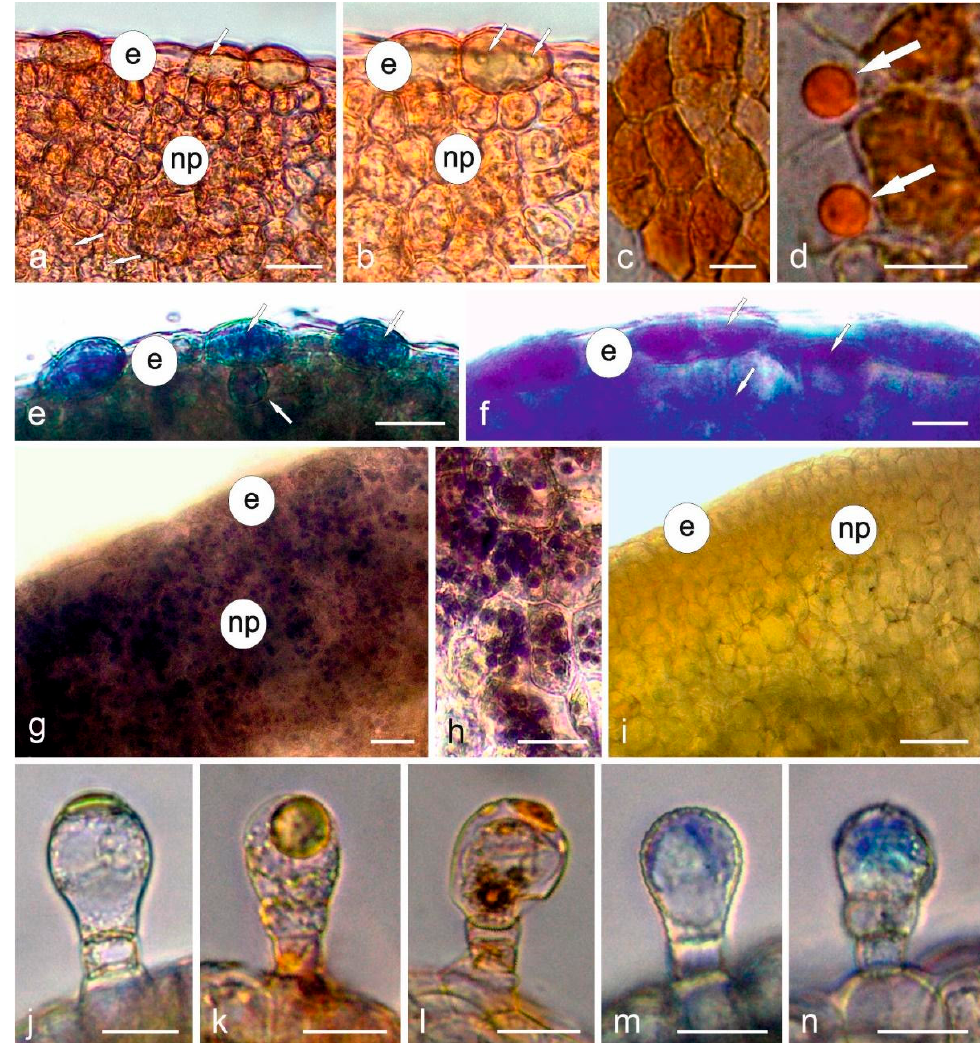
Figure 5. Results of histochemical tests of Dracocephalum moldavica nectary cells. Light microscopy (LM)—cross-sections. ( a , b ) Lipid compounds stained orange with Sudan IV in epidermal (white arrows) and parenchyma cells; ( c , d ) Lipid compounds in epidermal cells stained orange with Sudan IV—top view. Note the large lipid droplets (white arrows); ( e ) Acid lipids stained blue with Nile blue in the epidermis and parenchyma (white arrows); ( f ) Neutral lipids (essential oil) stained purple with Nile blue present in epidermal and parenchyma cells (white arrows); ( g , h ) Neutral polysaccharides (starch grains) stained purple with Lugol’s solution in nectary parenchyma cells in the swollen bud stage; ( i ) Starch-free nectary cells treated with Lugol’s solution in a freshly opened nectar-secreting flower; ( j – n ) Glandular trichomes on the nectary surface; ( j ) — control, in water; ( k , l ) Glandular trichomes treated with Sudan IV with visible orange content; ( m , n ) Phenolic compounds stained with toluidine blue in trichome heads; e—epidermis; np—nectary parenchyma. Scale bars: 50 μ m ( i ), 20 μ m ( a , b , e , g , h , j – n ), 10 μ m ( c , d , f ).